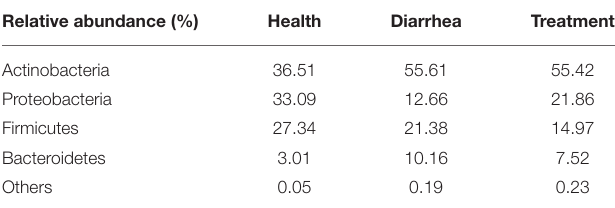
TABLE 3 | Relative bacterial abundance at the phylum level in each group. Relative abundance (%) Health